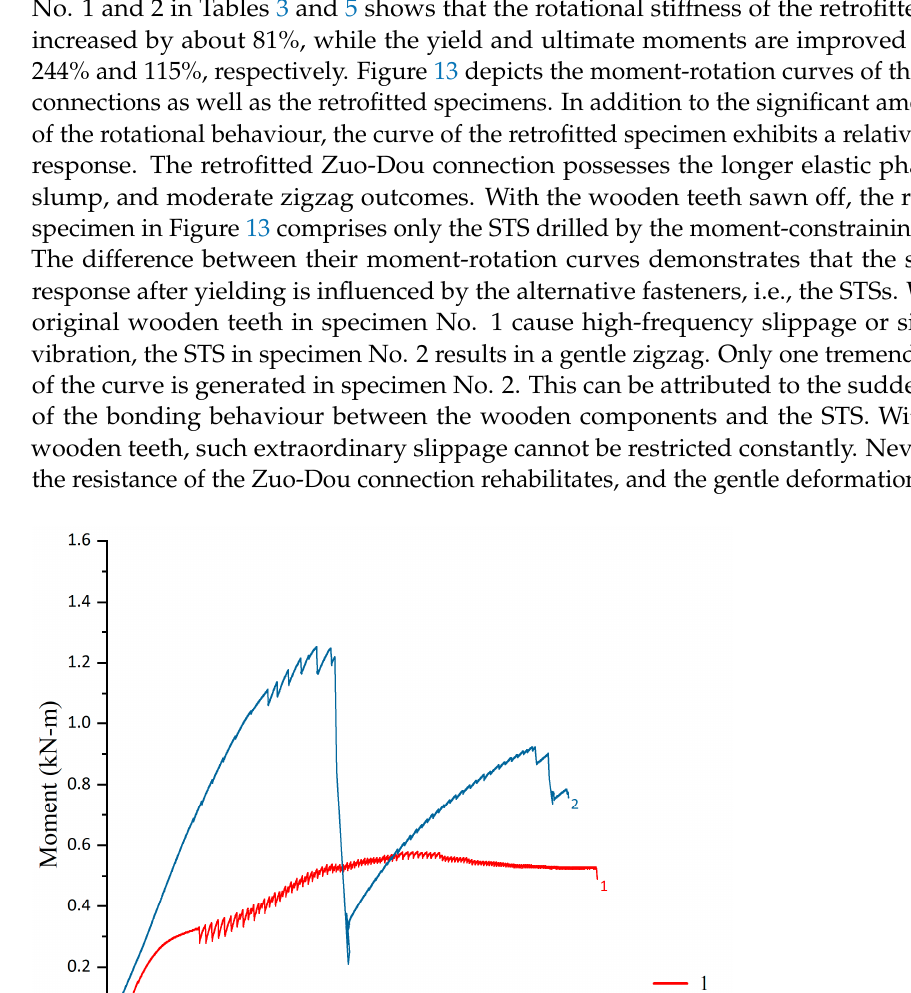
Table 6. Efficiency of preventing reinforcement for rotational behaviour *.